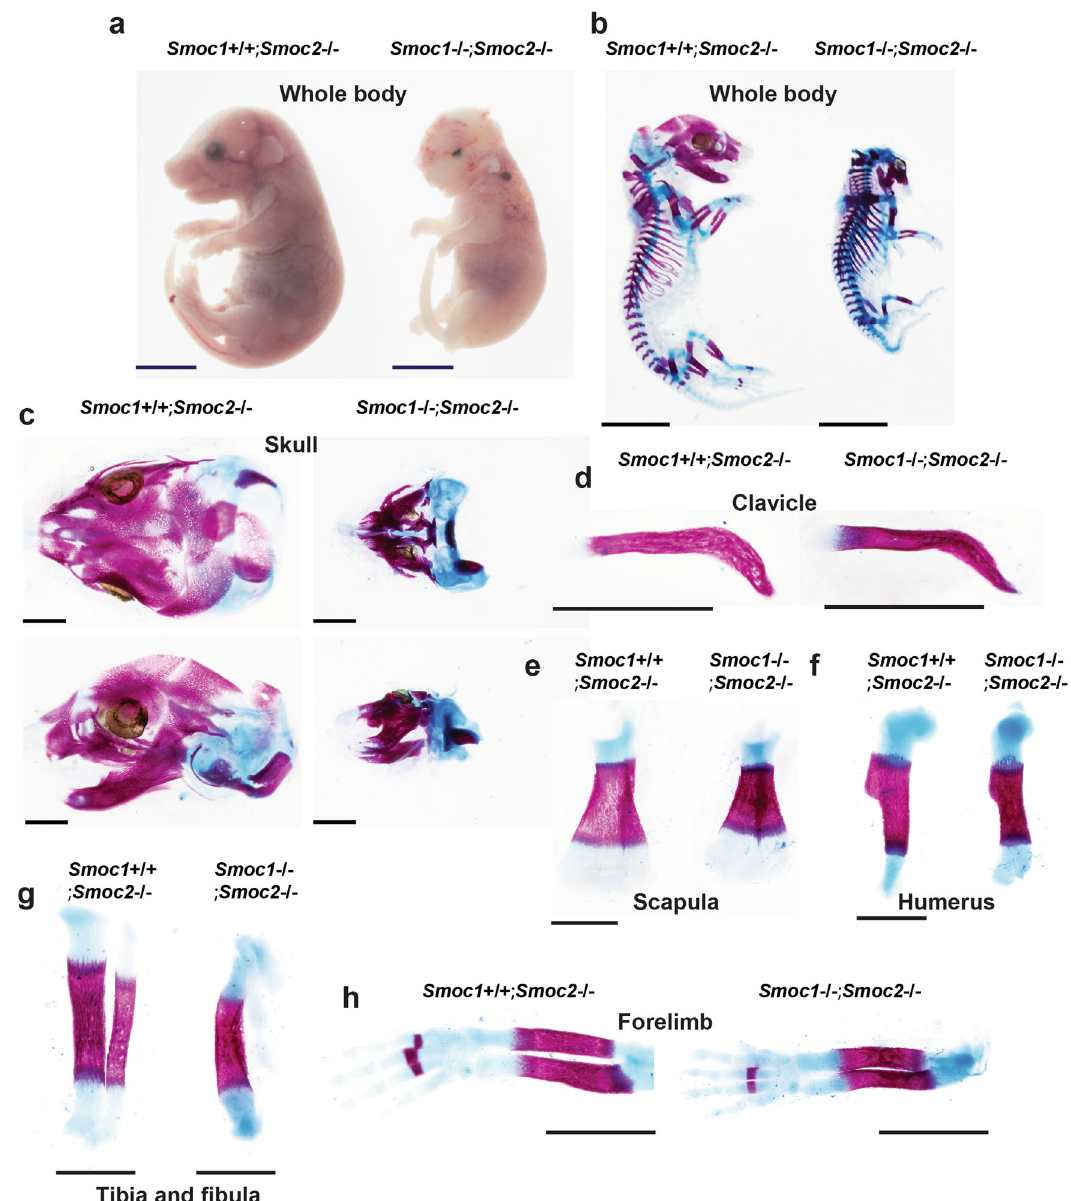
Fig. 4 Skeletal abnormalities in Smoc1/2 DKO mice. Smoc1 + / − ; Smoc2 − / − mice were mated, and Smoc1 + / + ; Smoc2 − / − and Smoc1 − / − ; Smoc2 − / − littermate mice were analyzed at E17.5 macroscopically under a stereoscopic microscope ( a ) and by skeletal preparations stained with alizarin red and alcian blue ( b – h ). a Growth retardation in Smoc1 − / − ; Smoc2 − / − mice. Staining in the whole body ( b ), skull ( c ), clavicle ( d ), scapula ( e ), humerus ( f ), tibia and fi bula ( g ), and forelimb ( h ) of Smoc1 + / + ; Smoc2 − / − and Smoc1 − / − ; Smoc2 − / − littermate mice. a , b Scale bars: 5 mm. c – h Scale bars: 1